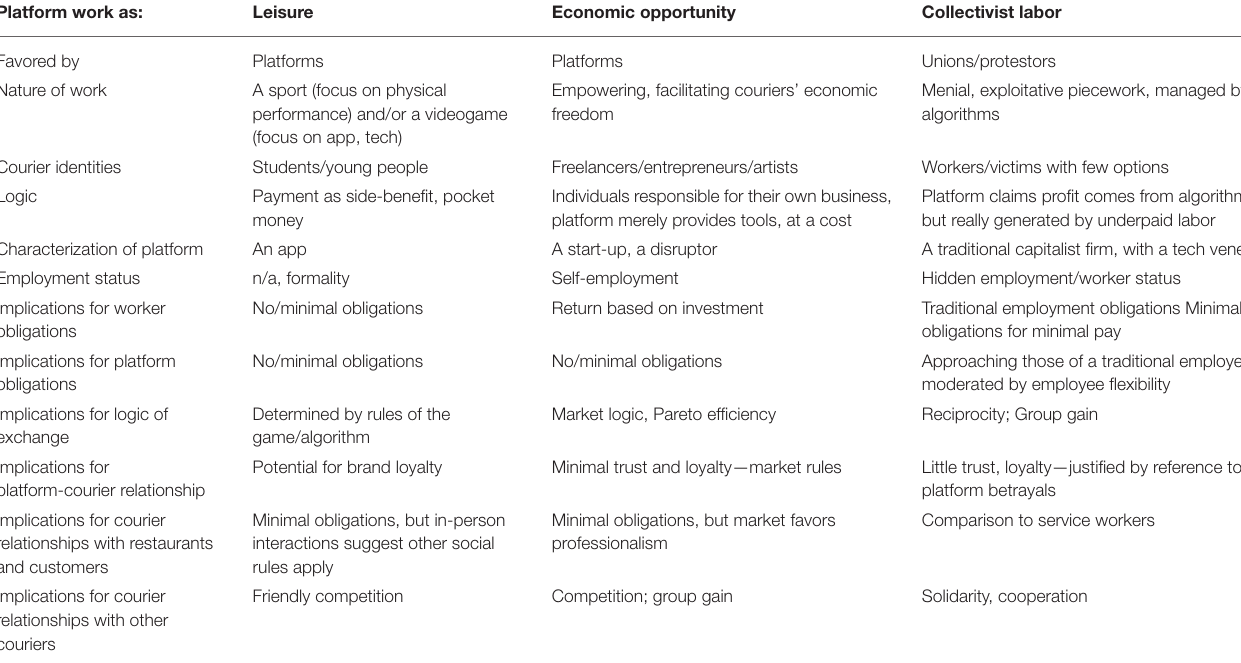
TABLE 2 | Narratives informing courier expectations. Platform work